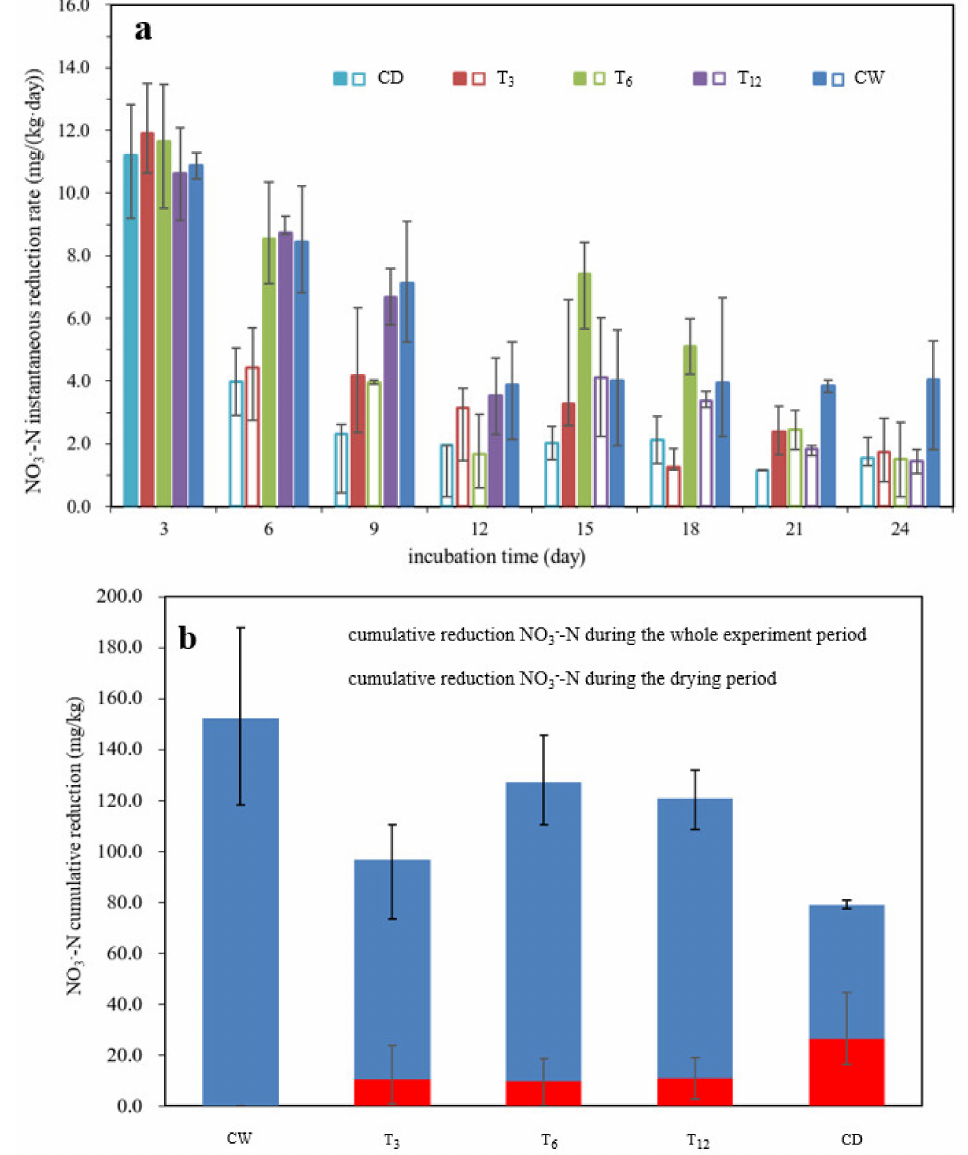
Figure 3. Instantaneous reduction rate of NO 3 − -N in different treatments. ( a ) The solid and hollow boxes represent the soil in the rewetting and drying period, respectively; ( b ) Cumulative reduction of NO 3 − -N in different treatments. The vertical bars refer to one standard deviation ( n =